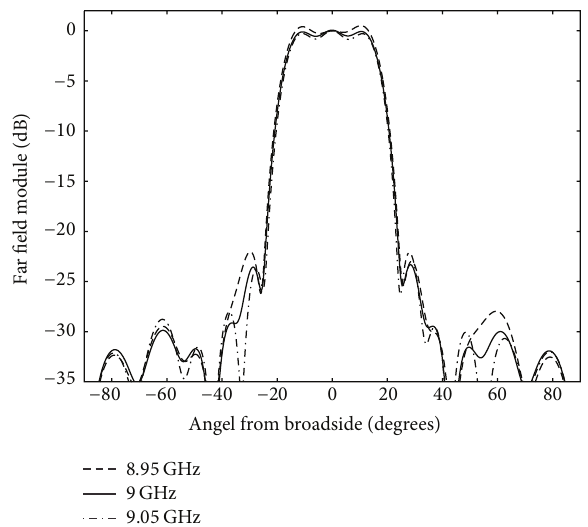
Figure 12: Simulated 𝐻 -plane far field of the 8 × 8 array with a circular radiation pattern.